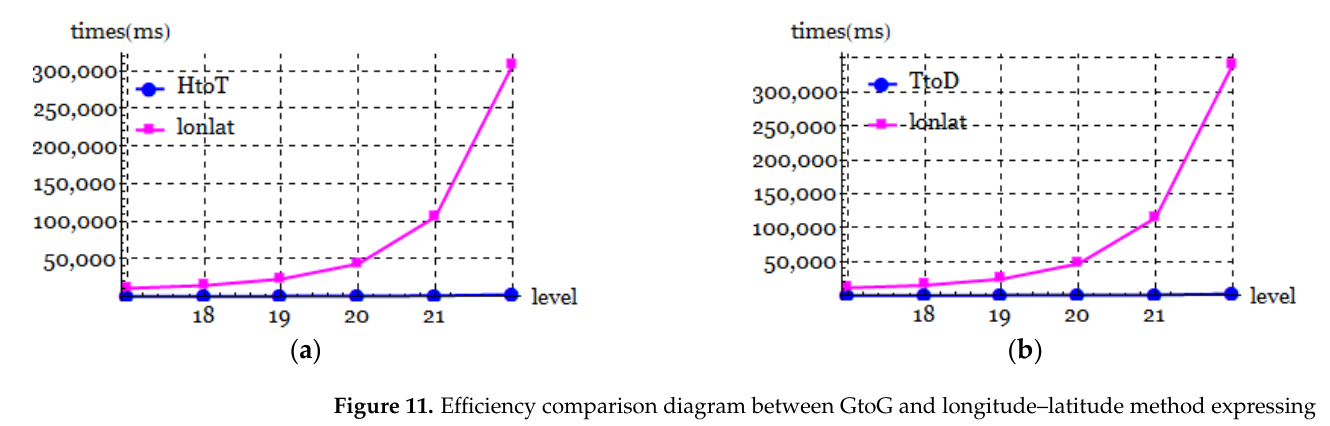
ing discrete lines. ( a ) Efficiency comparison curve between HtoTcode and longitude–latitude method, and ( b ) Efficiency comparison curve between TtoDcode and longitude–latitude method.